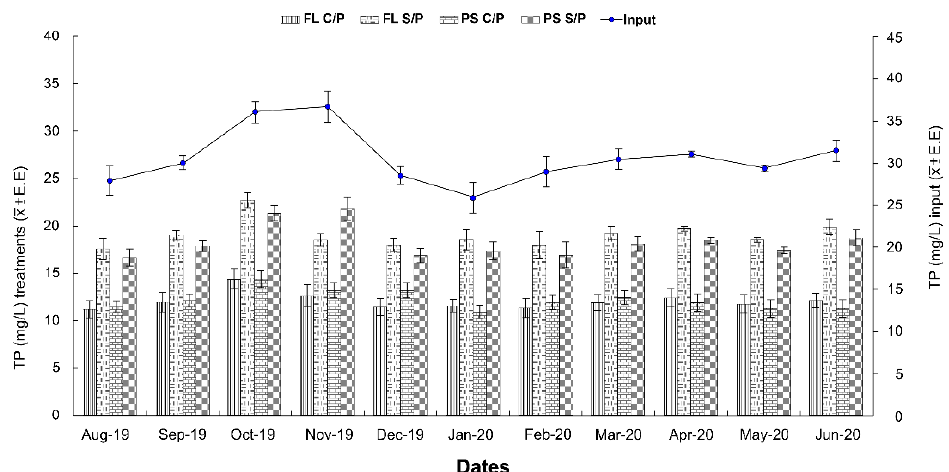
Figure 8. Average TP concentrations ( ± E.E.) during the experiment. (FLCP: free flow with plant; FLSP: free flow without plant; PSCP: saturated flow with plant; PSSP: saturated flow with plant; E.E.: standard error).